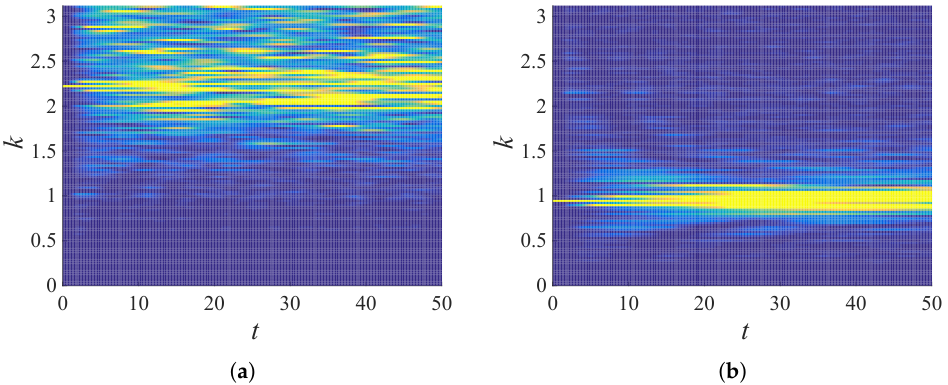
Figure 11. Total energy response ( TE ( k ) ( t ) ) in wavenumber space plotted against time for a single realization of disordered granular chain ( ξ = 0.3) initially agitated with ( a ) k ins = 2.159 ( = and ( b ) k ins = 0.981 ( N